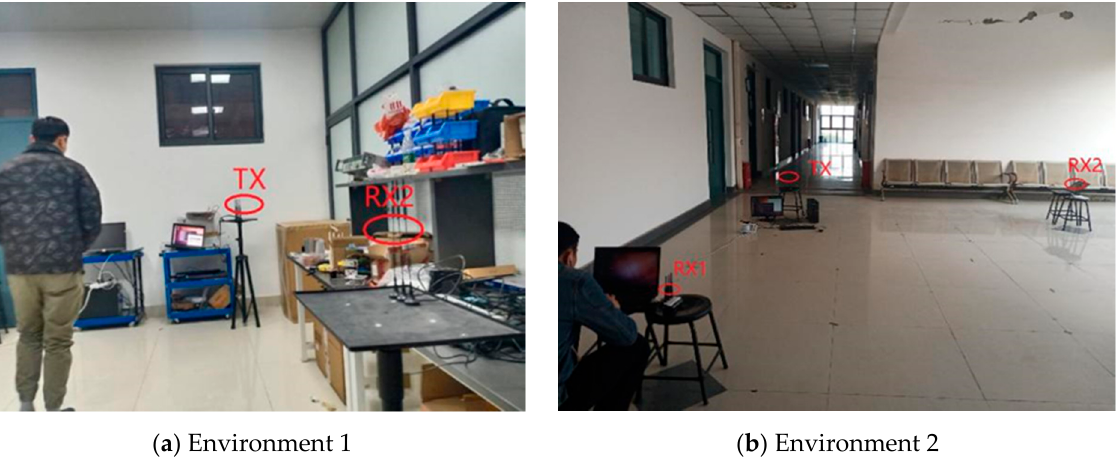
Figure 7. The experimental environments.